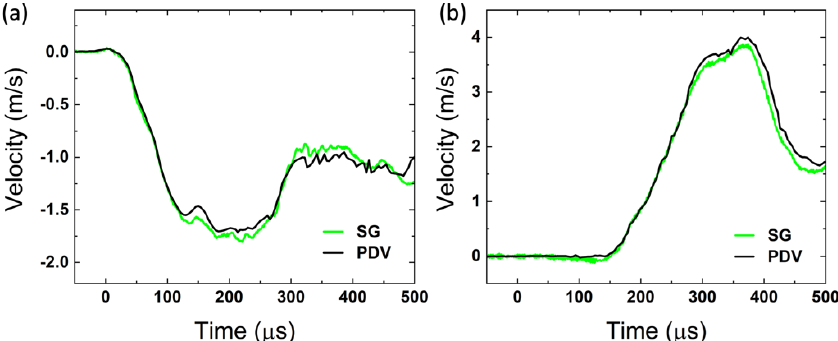
Fig. 4. Comparison of the longitudinal (a) and rotational (b) velocity profiles measured by the strain gauges (SG) and the PDV